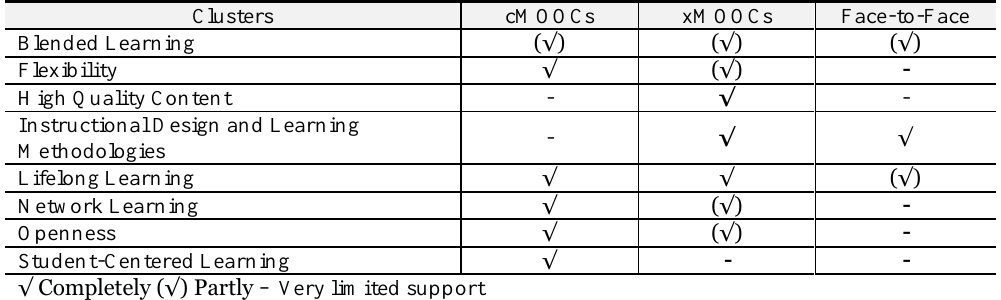
Stakeholder Perspectives in cMOOC, xMOOC, and Face-To-Face Learning